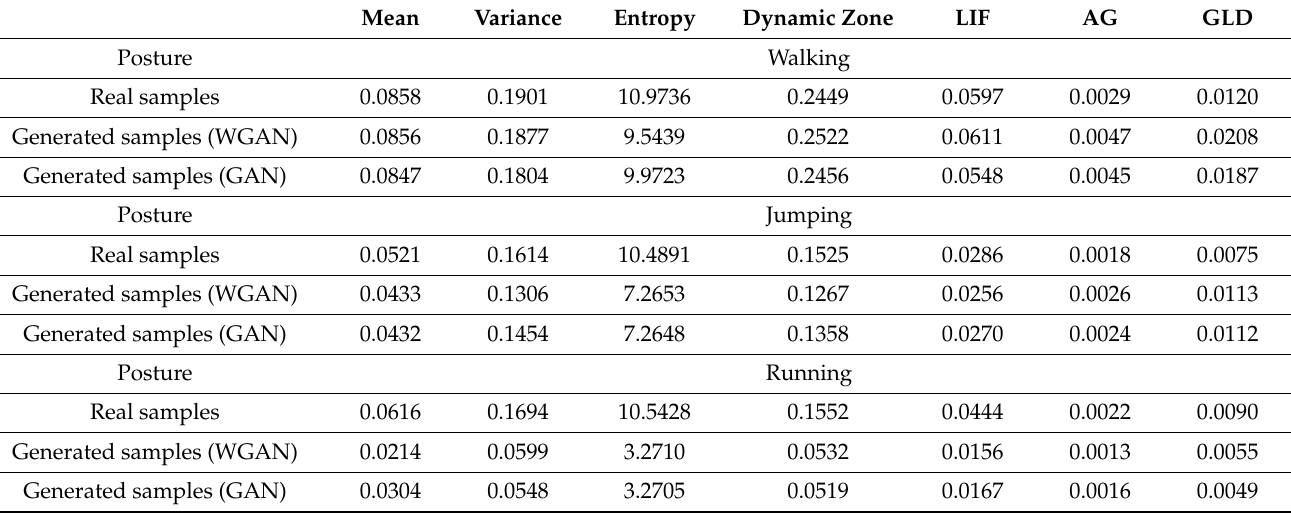
Table 5. Values of the seven evaluation metrics of the generated samples from the database obtained from the MOCAP and EM data. Mean Variance Entropy Dynamic Zone LIF AG